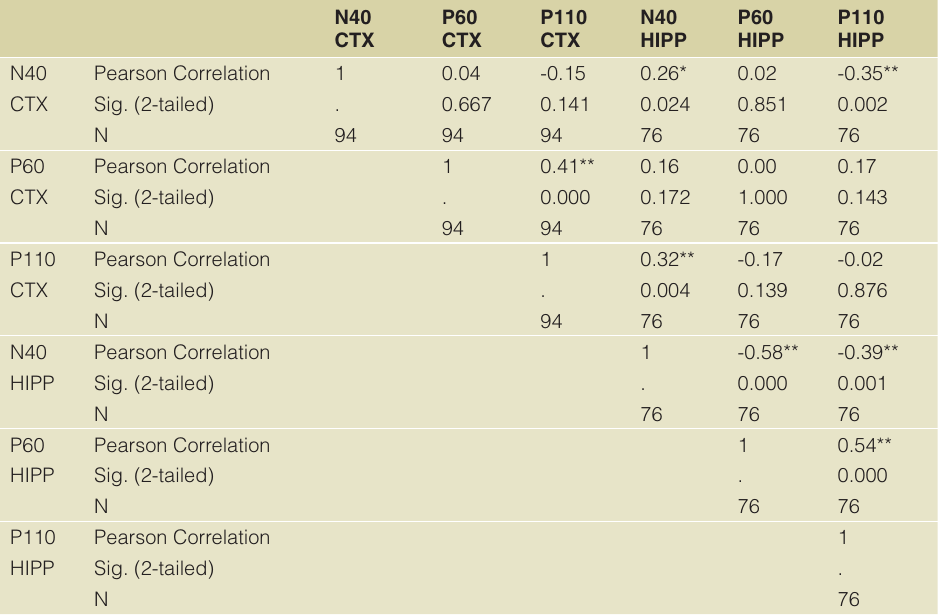
Table 2. The correlation matrix for middle-latency components (pooled data from Experiment 1 &